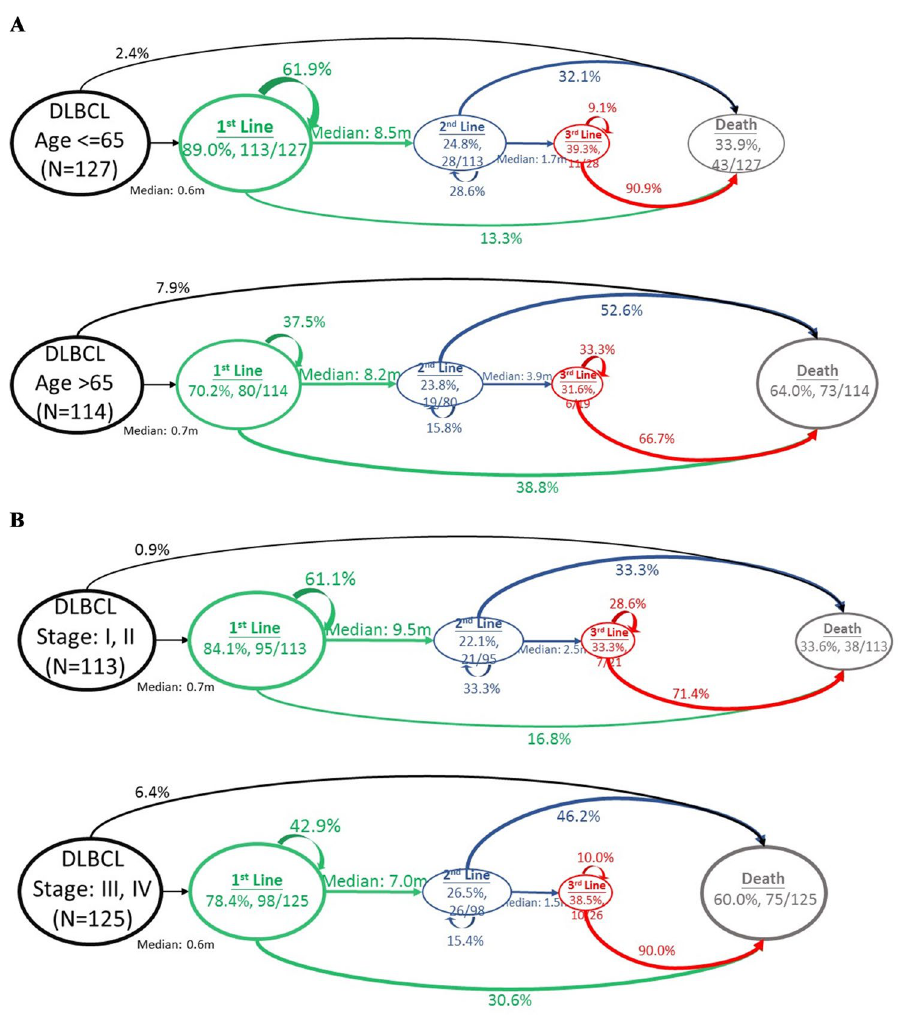
Figure 7. Disease progression model for DLBCL by ( A ) age and ( B ) disease stage at diagnosis. DLBCL, diffuse large B-cell